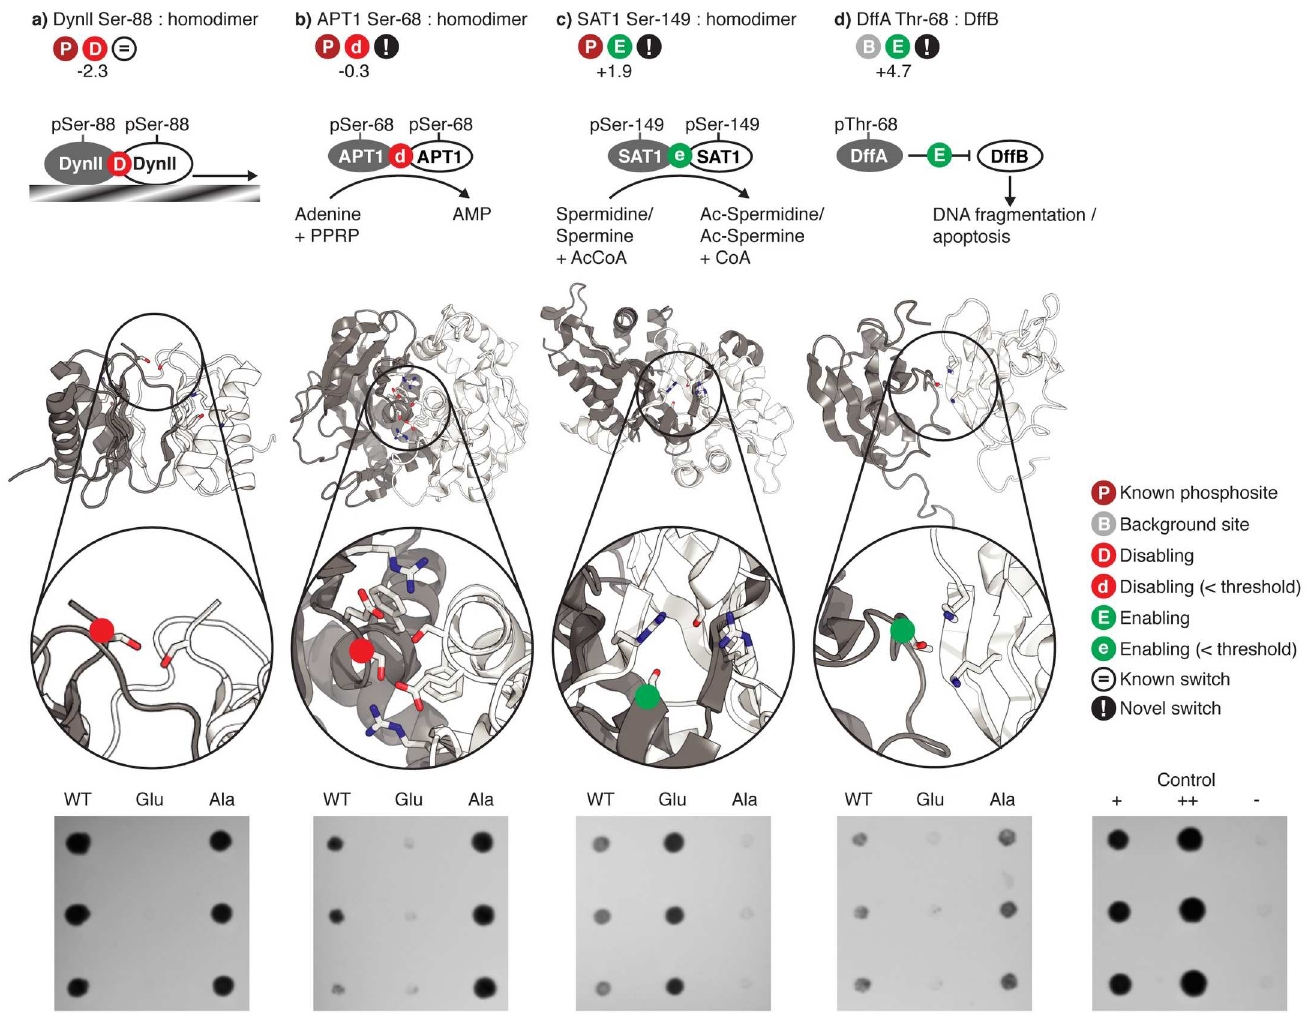
Fig 3. Experimental verification of known and predicted phosphoswitches using wild-type (wt), Glutamate and Alanine mutants in the yeast two-hybrid system. Phosphorylated proteinsare shown in grey and the proteins with which they interact are shown in white. The sidechains of phosphosites and the residueswith whichthey interactare shownas sticks coloured by atom type. Phosphosites are indicatedby coloureddots on C-alpha atoms. S switch scores are shownbesidesenablingor disablingsymbols. a) the knowndisablingsite Ser-88in humanDynein[40]is observed to be disabling, with wild-type and Alaninemutants growingbut not the Glutamatemutant. b) Phosphorylation of Ser-68in yeast Adenine phosphoribosyltransferase (APT1) was predicted to weaklydisablethe homodimerinteractionby contactingitself and otherchargedresiduesin the homodimeric interface[55],which is requiredfor conversion of Adenine to AMP, anda disablingeffect was observed. c) Phosphorylationof Ser-149in humandiaminacetyltransferase1 (SAT1) was predicted to enableformationof homodimers [56]requiredfor spermidine/spermineacetylationand wasobservedto be enabling(wild-type shows growth, Glutamate mutantsshow stronger growth, Alaninemutantshows no growth).d) MouseDNAfragmentation factor A (DffA) bindsto DffB, inhibitingDNAfragmentation. Phosphorylationof Thr-68of DffA is predictedto enableinteractions with DffB throughcontacts withtwo Lysines[57]but is observedto be disabling(wild-typeand Alaninemutants showgrowth, Glutamate doesnot).